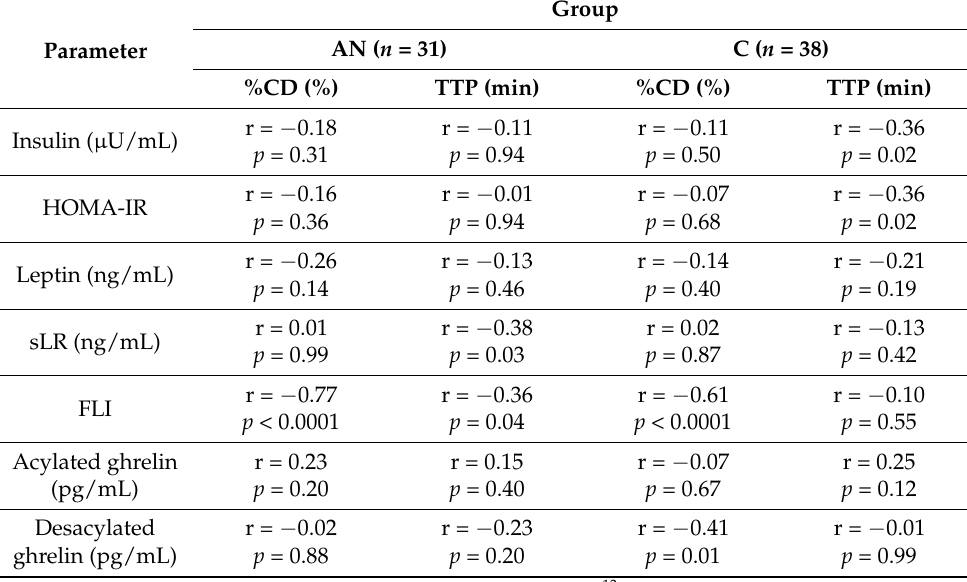
Table 3. Analysis of the correlation between the results of hormonal tests and the cumulative dose of 13 C-triglycerides recovered with exhaled air and the time from administration of 13 C-triglycerides to achieving peak 13 CO 2